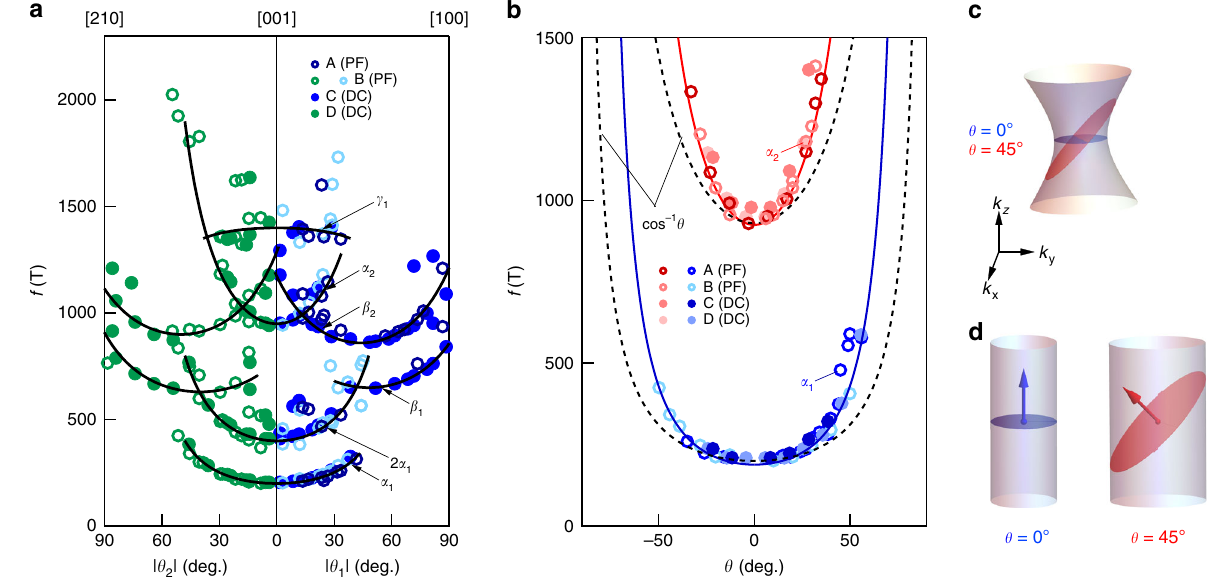
Fig. 2 Angular dependence of dHvA oscillation frequencies. a Angular dependence of all fast Fourier transform (FFT) frequencies with rotation from [001] to [010] (left panel) and from [001] to [210] direction (right panel). Empty circles are collected from pulsed fi eld experiments, while solid circles are from DC fi eld experiments. Data taken from different samples are represented with different colors. The black curves are guides to the eye. b Angular dependence of α 1 and α 2 pockets. The dashed lines are the behavior expected for a 2D cylindrical Fermi surface (1/cos θ ), and the solid lines are a massive Dirac model (see text). c Schematic of a hyperboloid Fermi surface whose smallest extremal area evolves faster than 1/cos θ with a rotating magnetic fi eld. d Schematic of quasi-2D Fermi surface where the k z -dispersionless Fermi wave vector changes with the direction of magnetization (shown as